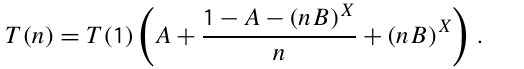
Table 2. Fit coefficients of modified Amdahl’s law (Eq. 2) for the three test cases and the two classes of architectures, with a com- mon value for the exponent X = 2 . 85. For the Blue Gene system, only the fit to for the 60–12km mesh should be used to estimate the required computing